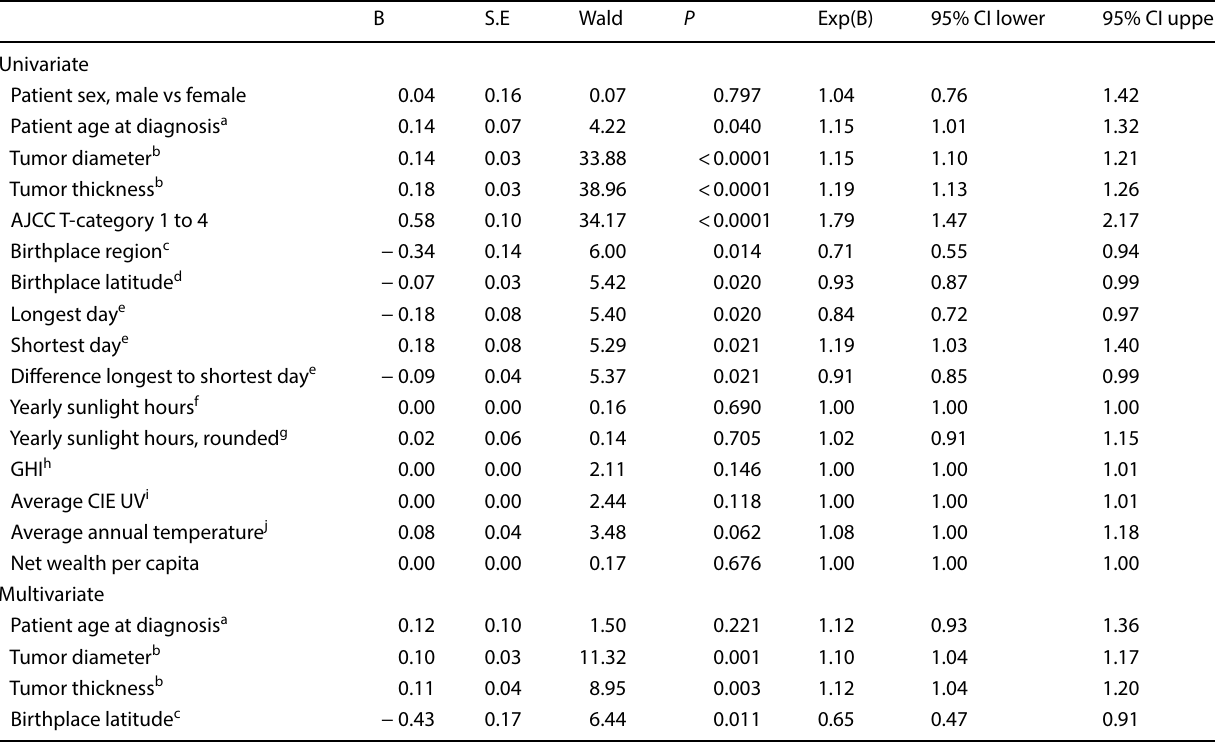
Table 2 Cox regressions, hazard for uveal melanoma-related death